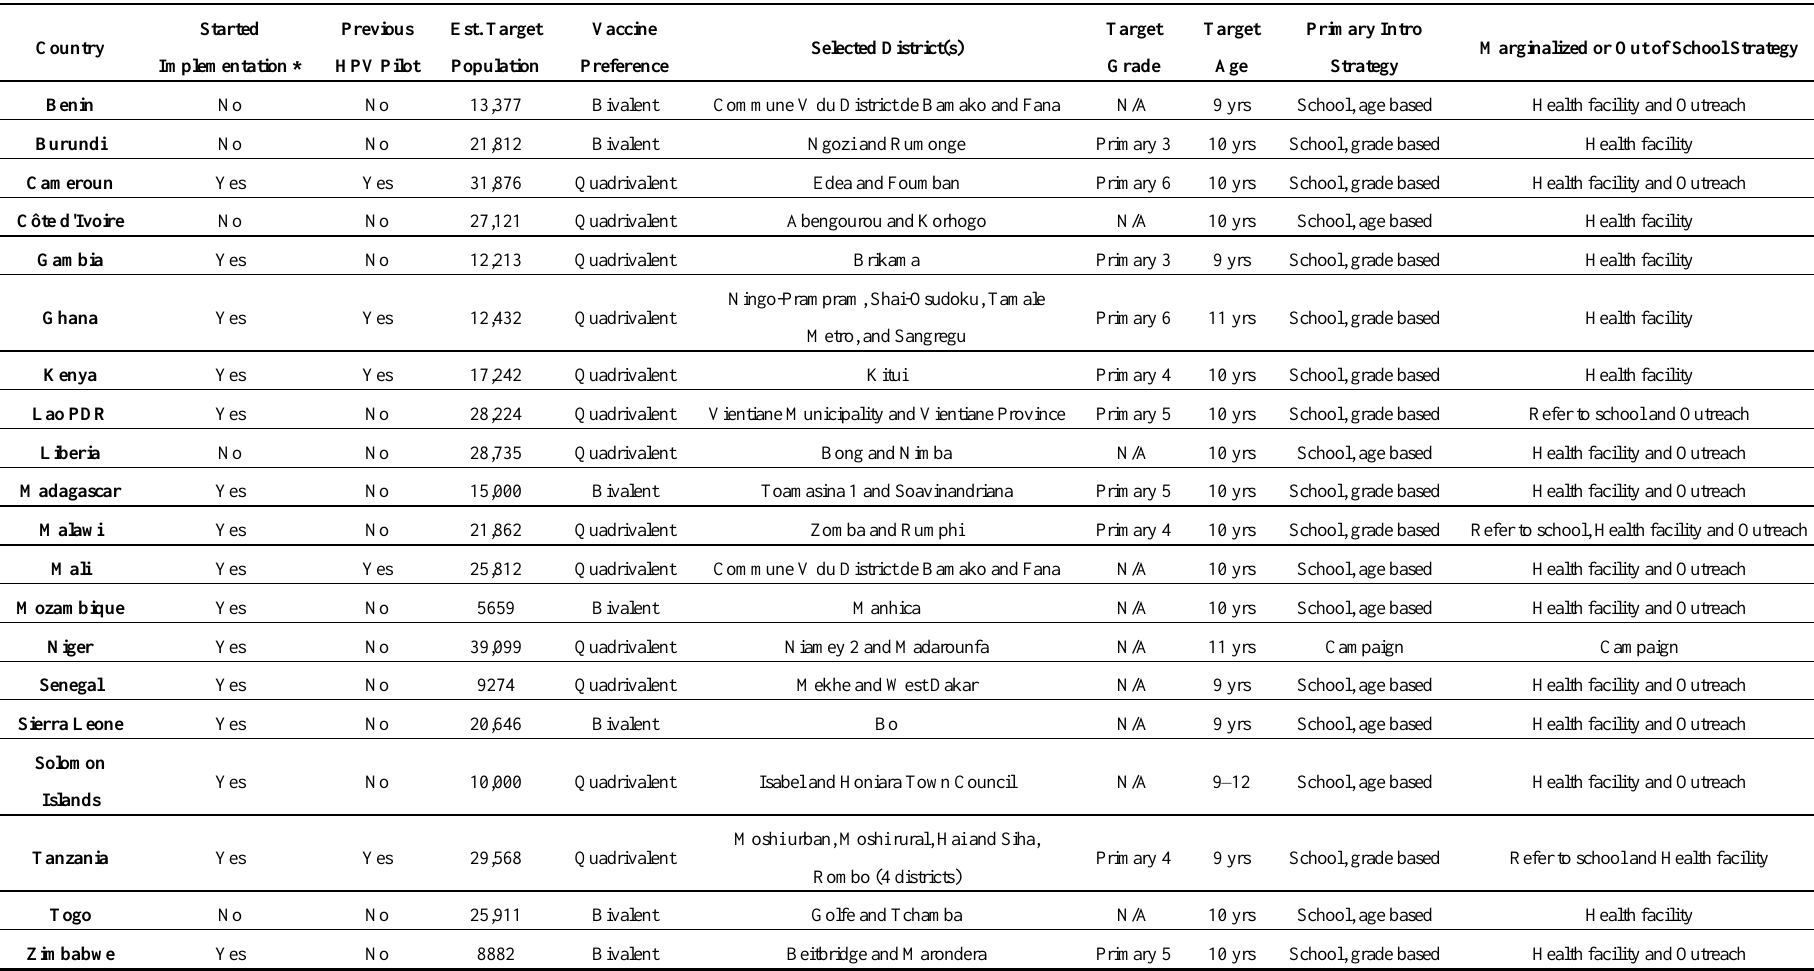
Table 1. Summary of Gavi Approved HPV Demonstration Program Proposals